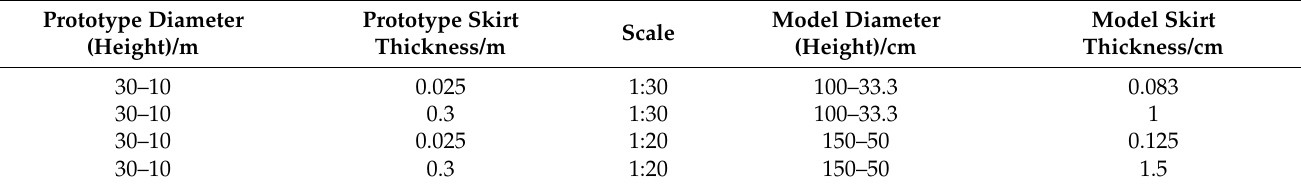
Table 1. Size comparison between the prototype and the test model.